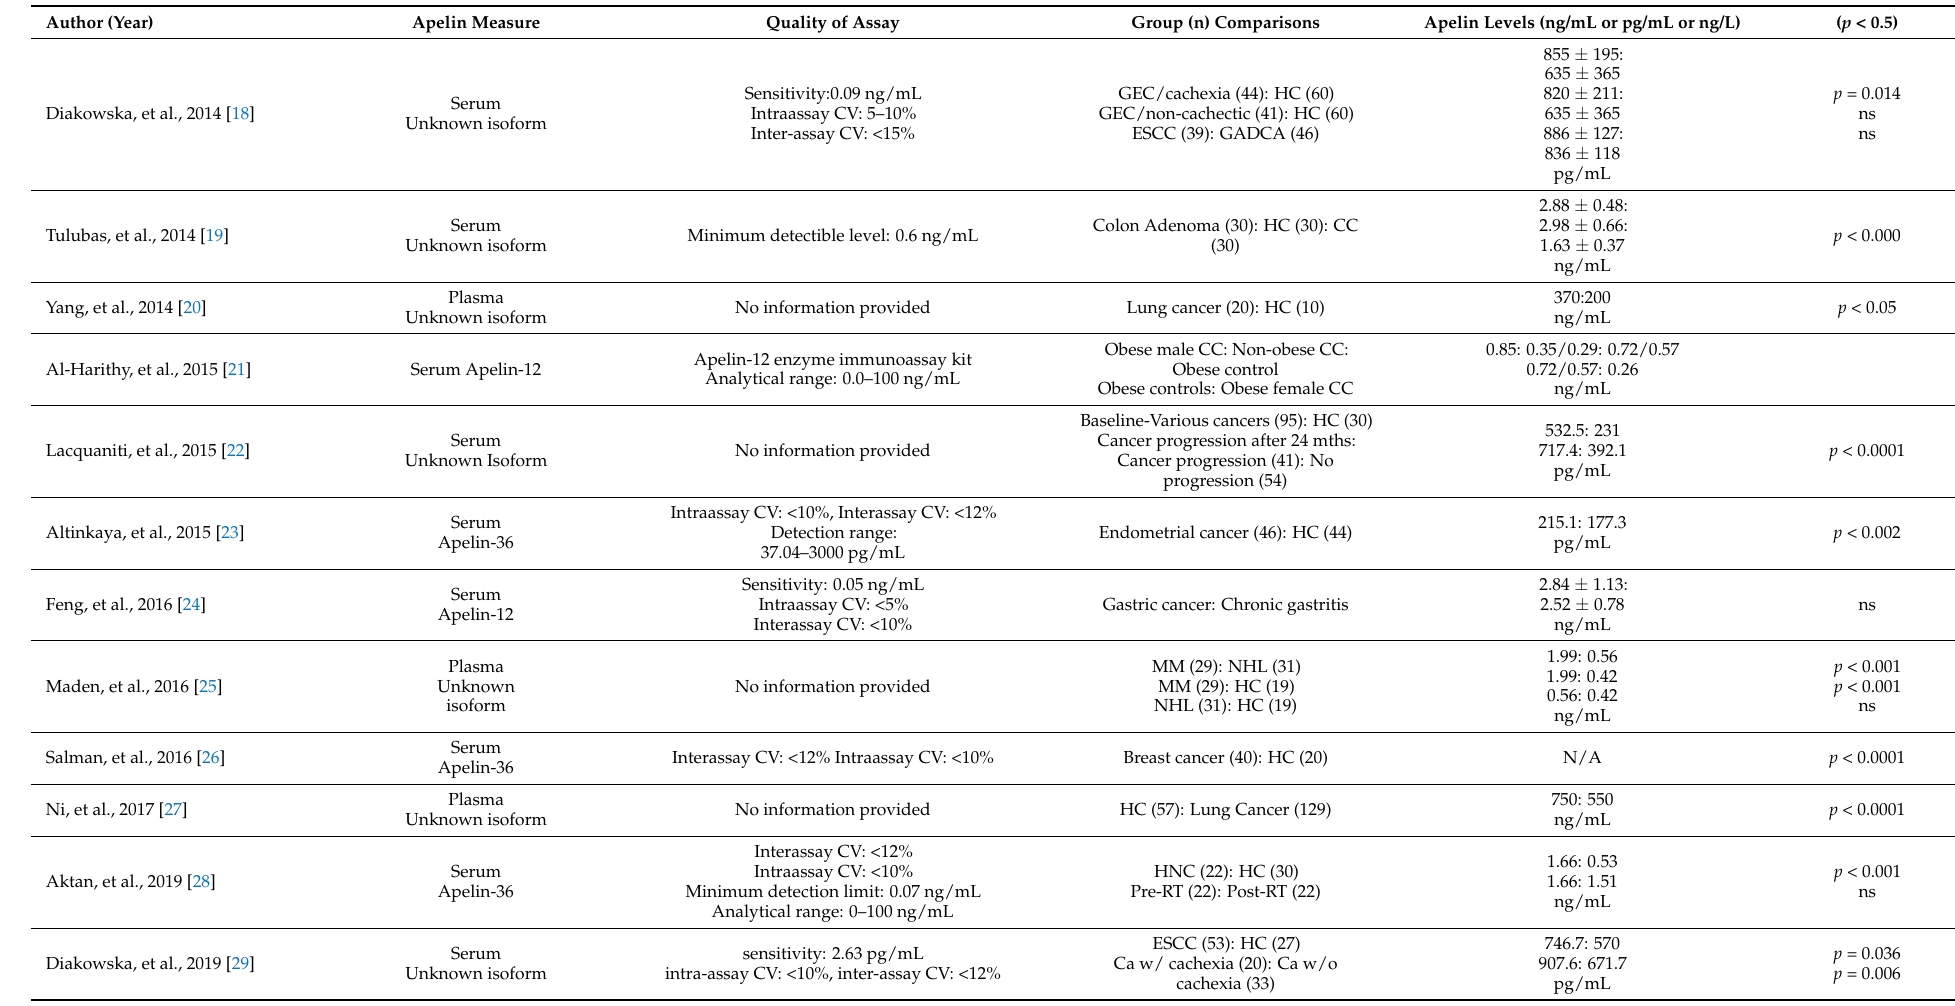
Table 2. Summary Description of findings on Apelin levels in case controls and